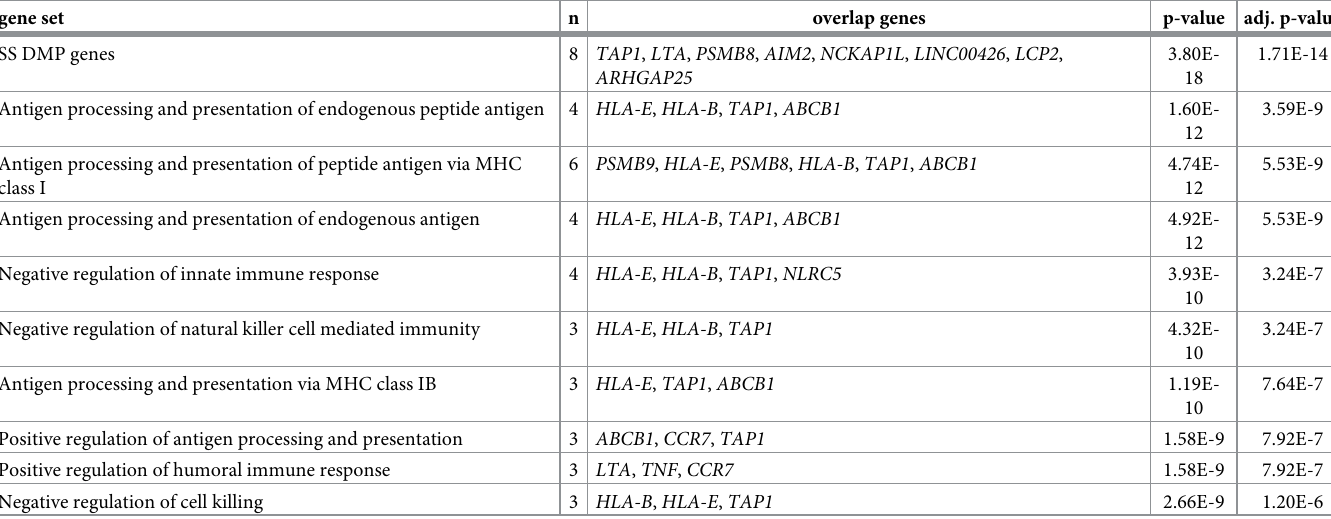
Table 2. Top gene sets enriched for hypomethylated genes in SS. gene